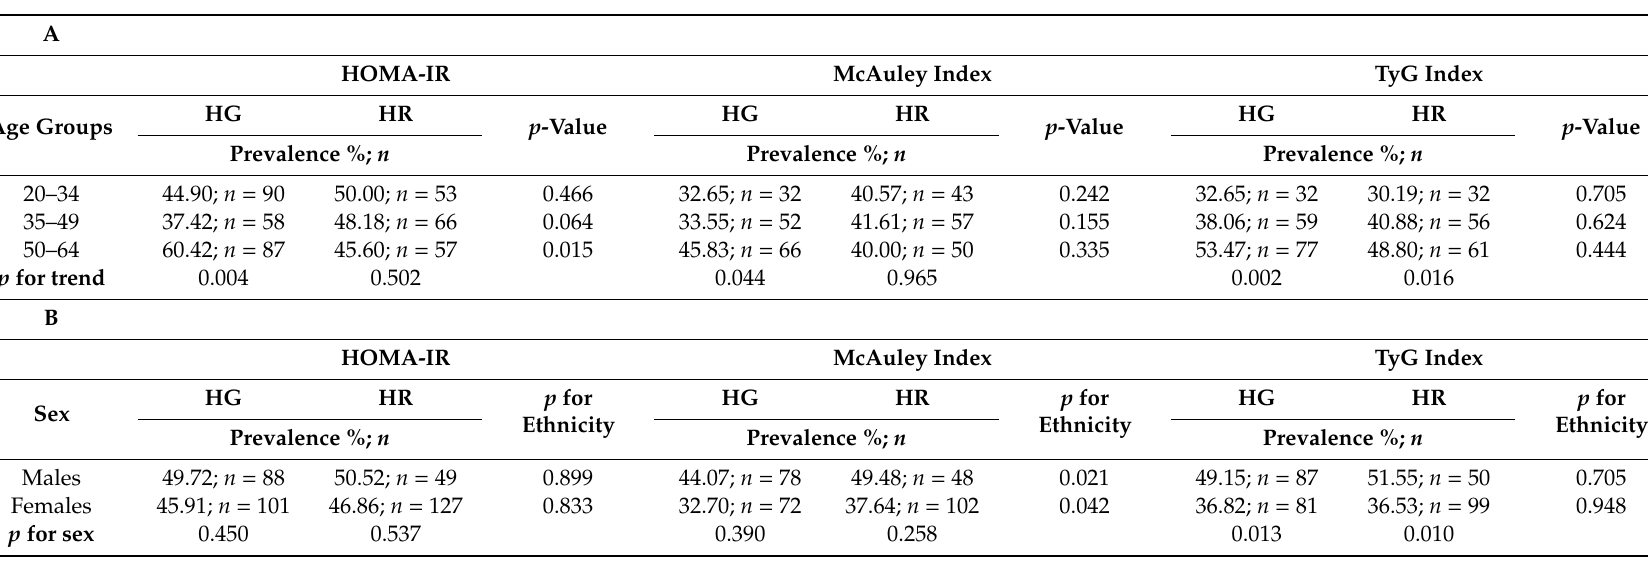
Table 7. Prevalence of insulin resistance based on the homeostasis model assessment of insulin resistance (HOMA-IR) index, McAuley index, and TyG index (calculated on the combined population) in the Hungarian general (HG, n = 397) and Hungarian Roma (HR, n = 368) populations by age group in years ( A ) and sex ( B